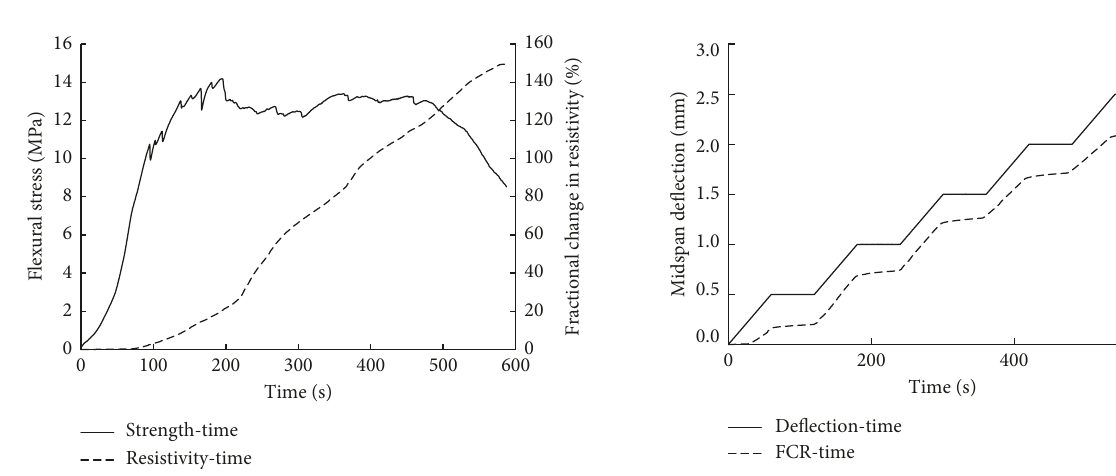
Figure 8: Self-sensing behavior of ECCs subjected to flexural loading.